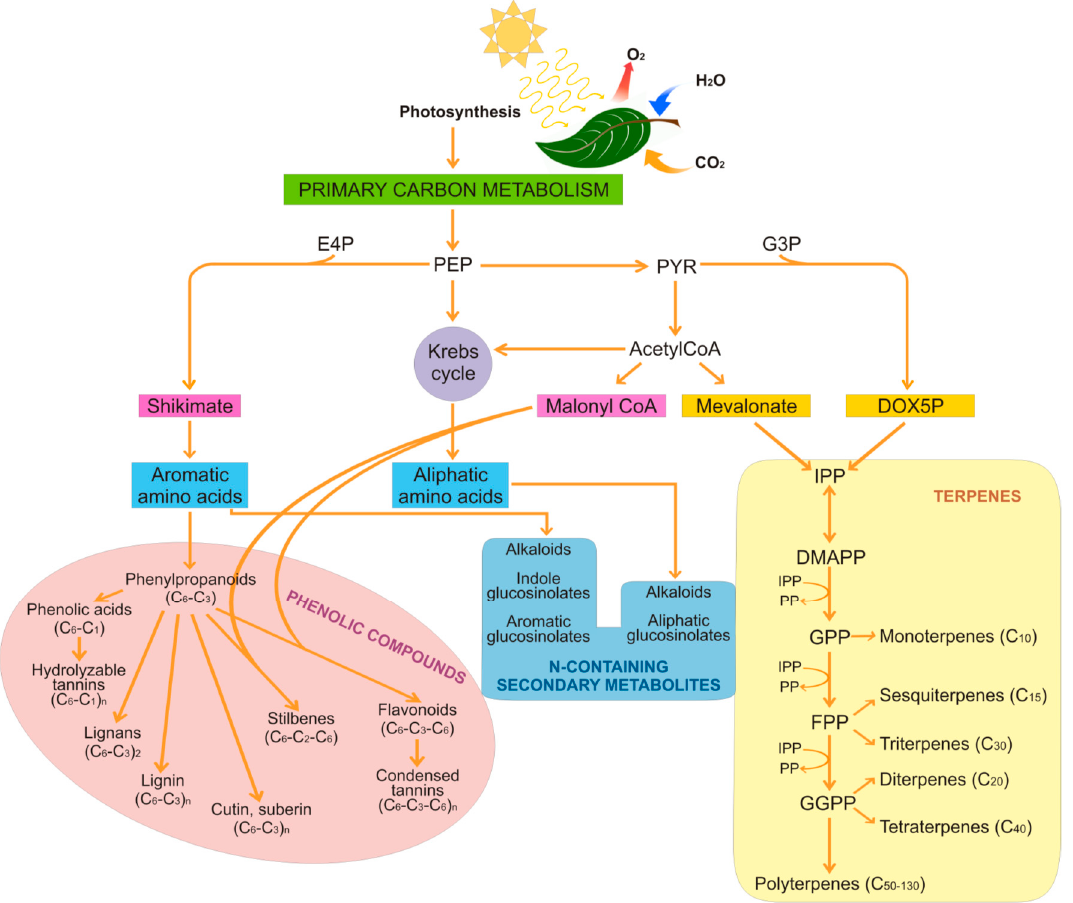
Figure 1. Schematic representation of the biosynthesis of secondary metabolites. E4P, erythrose 4-phosphate; G3P, glyceraldehyde 3-phosphate; PEP, phosphoenolpyruvate; PYR, pyruvate; DOX5P, deoxyxylulose 5-phosphate; IPP, isopentenyl pyrophosphate; DMAPP, dimethylallyl pyrophosphate; PP, pyrophosphate; GPP, geranyl pyrophosphate; FPP, farnesyl pyrophosphate; GGPP, geranylgeranyl pyrophosphate.